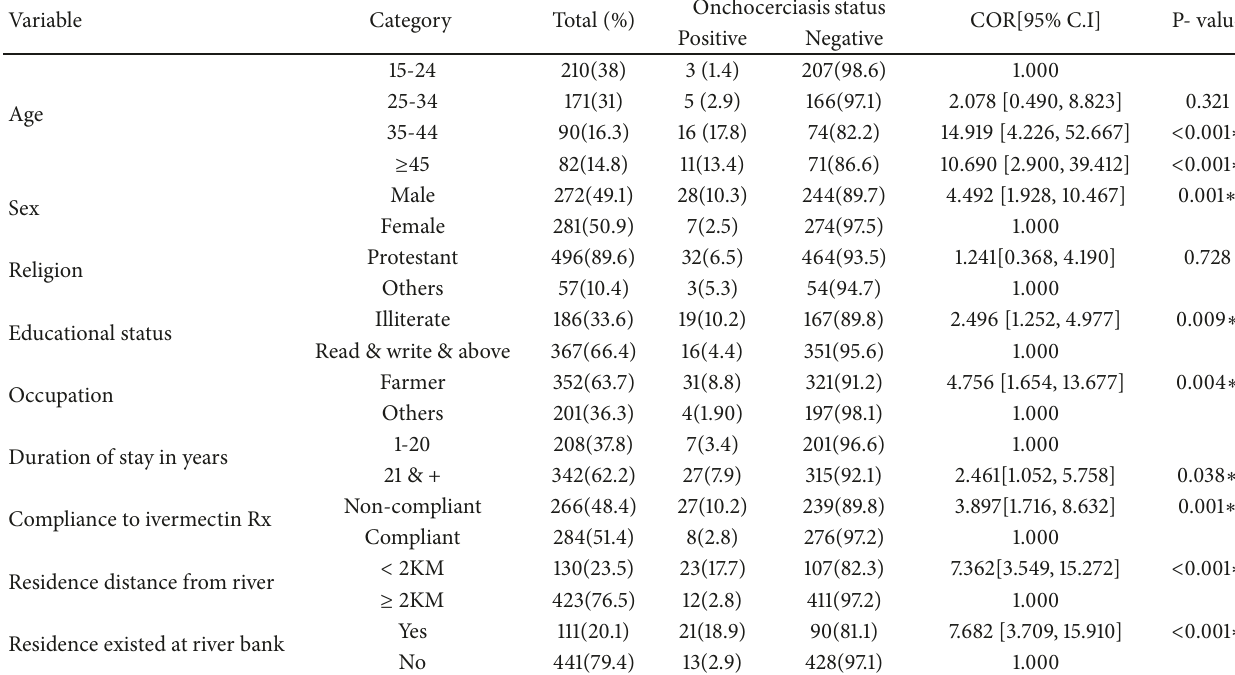
Table 4: Results of bivariate analysis on onchocerciasis and associated factors among adults aged ≥ 15 years in Semen Bench district, Bench Maji Zone, Southwest Ethiopia, June 2018 (n=553).